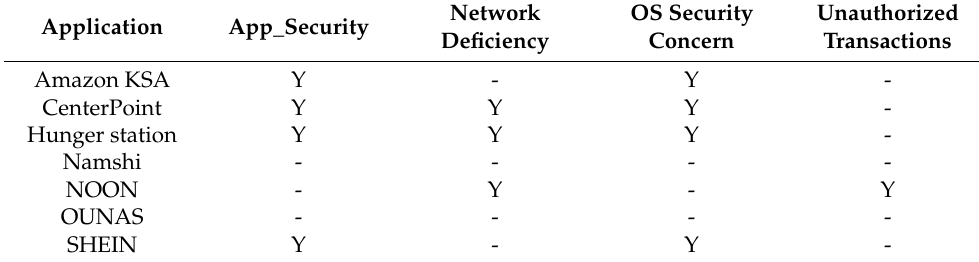
Table 11. Credit Card Security